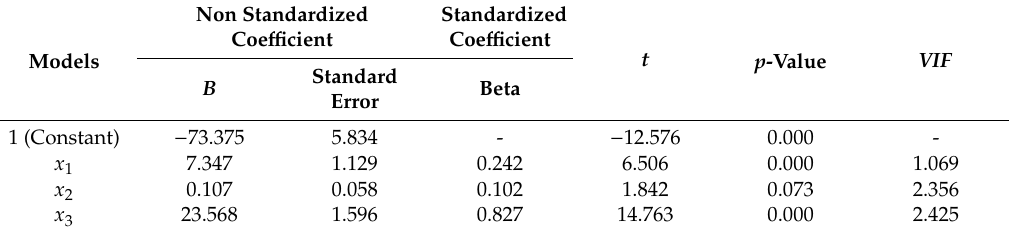
Table 3. Regression coe ffi cients based on the enter